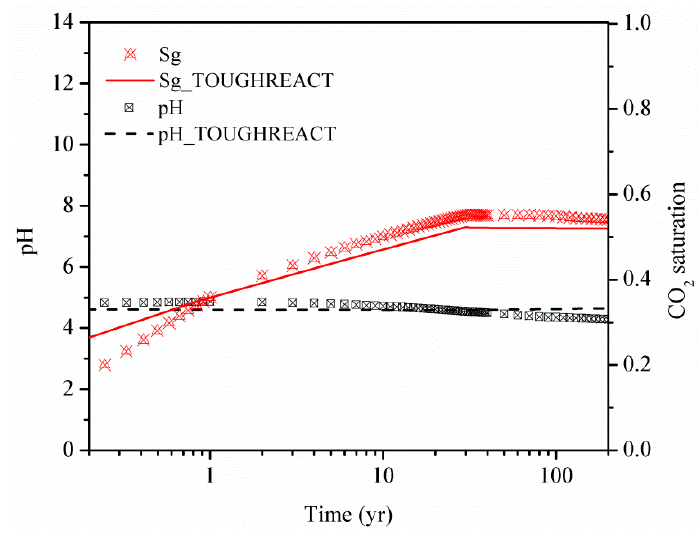
Figure 4. Comparison of the gas saturation and pH change with time in the injection cell using the two numerical programs—GEM and TOUGHREACT.